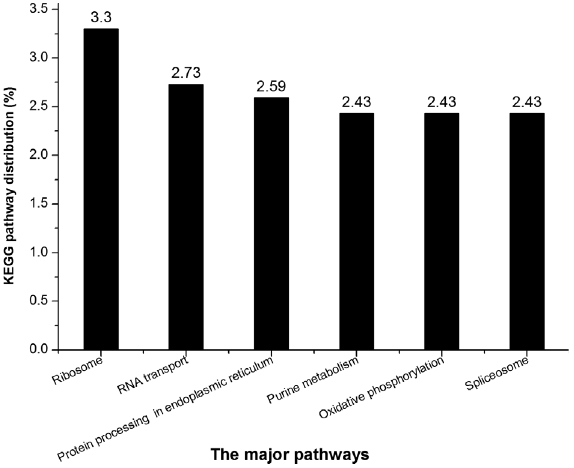
Figure 6 - Similarity analysis based on the BLAST best